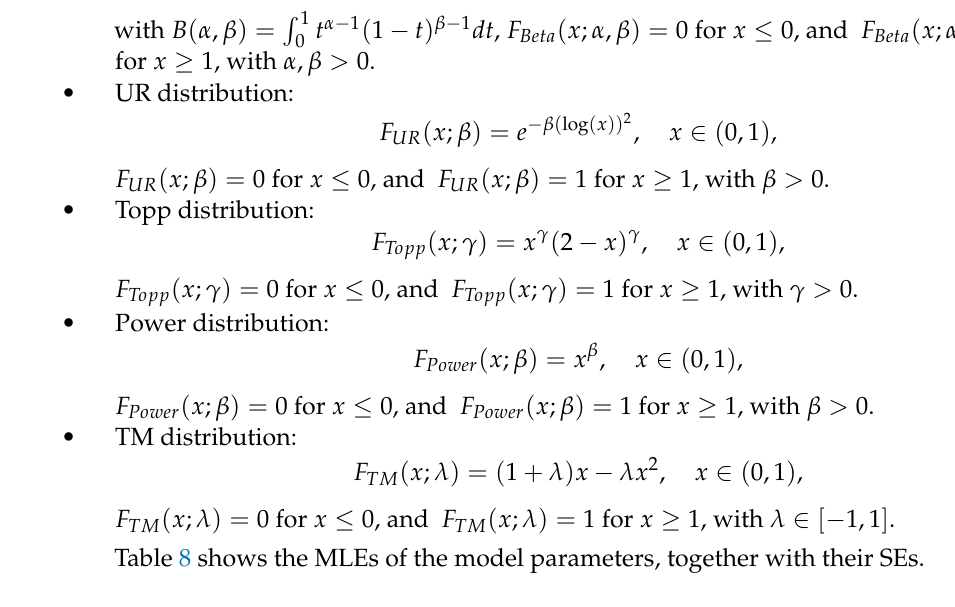
Table 8. Estimates (MLEs and SEs under parentheses) associated to the model parameters for the trade share data set.